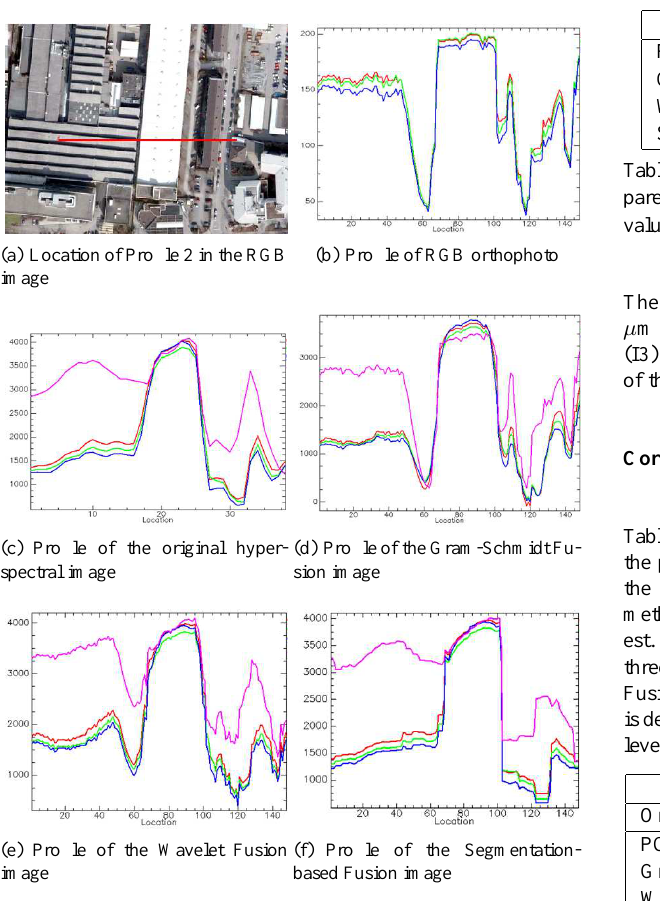
Figure 8: Profile 3 for different Fusion Methods